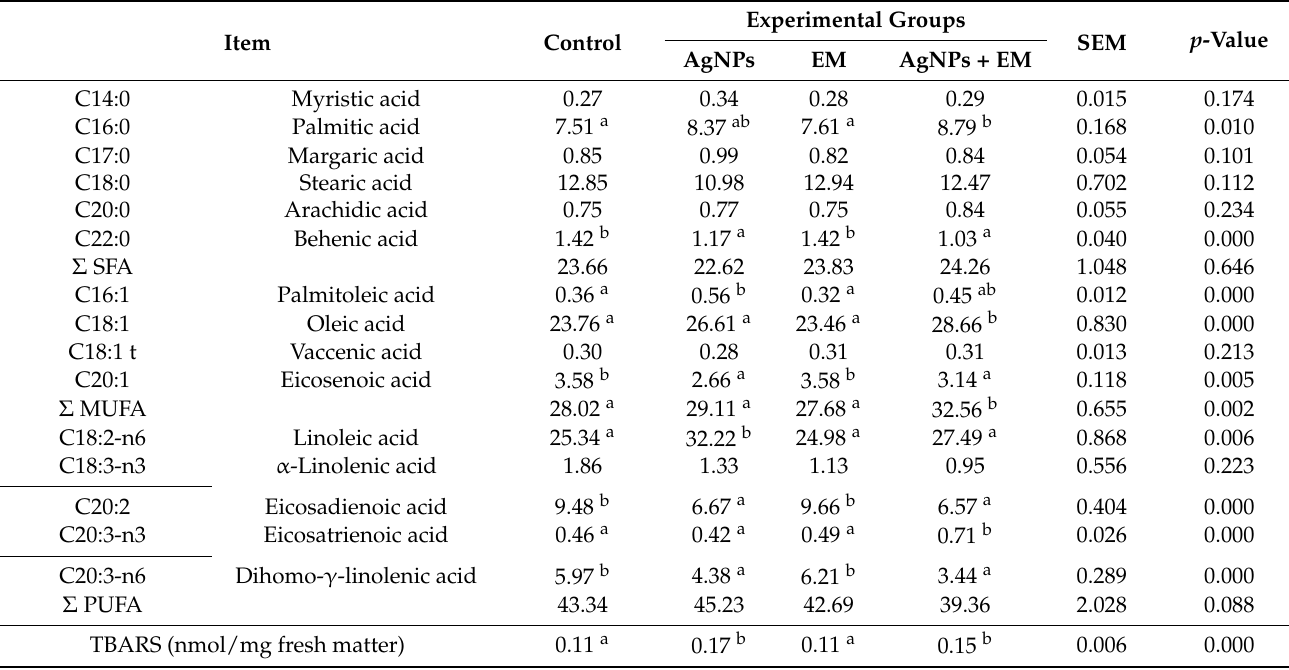
Table 3. Fatty acid composition and TBARS content in the snail carcasses in the control and experimental groups.